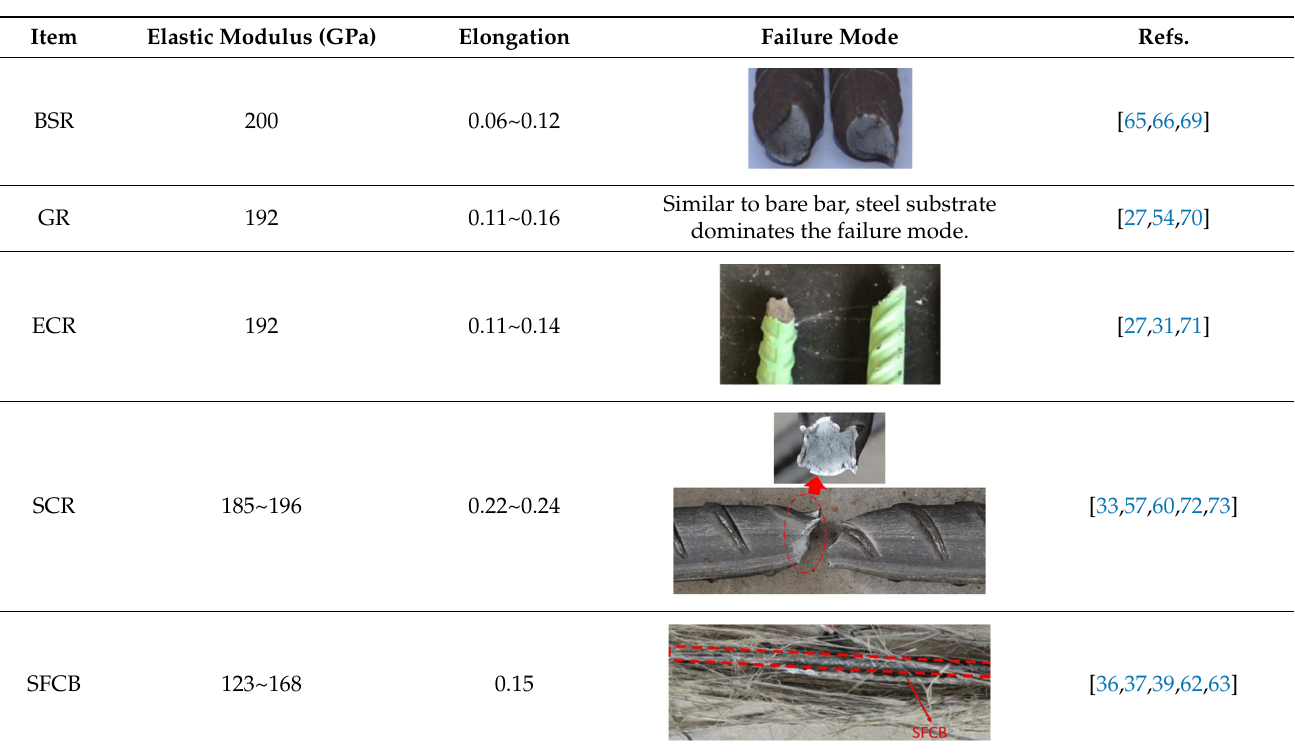
Figure 4. Comparison of typical tensile properties of GR [70], ECR [27], SCR [74], and SFCB [75]. 3.2. Fatigue Properties In coastal constructions, seismic performance is always considered because plate activity is relatively active in coastal areas. Coastal areas also need anti ‐ corrosion reinforcements. As confirmed by Sheng and Gong [76], stress events caused by earthquakes are those of low ‐ cycle fatigue. Investigations of GRs and ECRs are deficient.